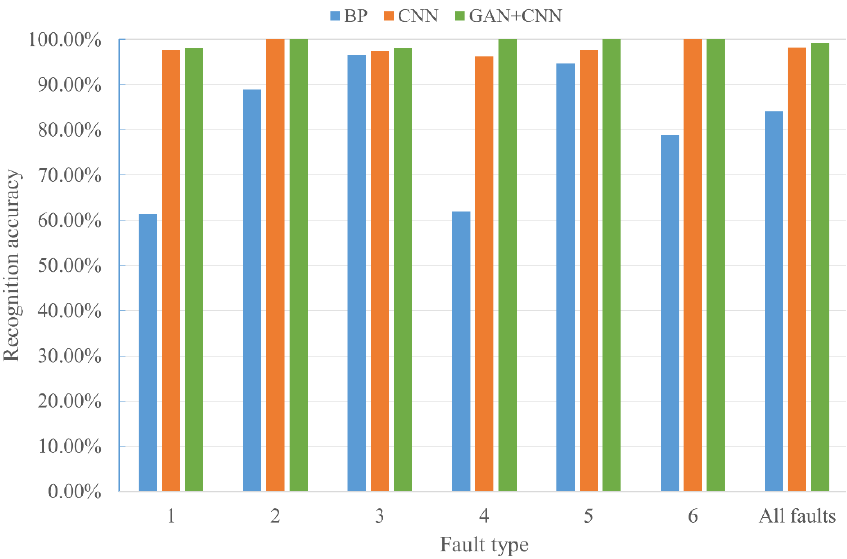
Figure 13. The comparison of each fault and the total identification accuracy of different methods.